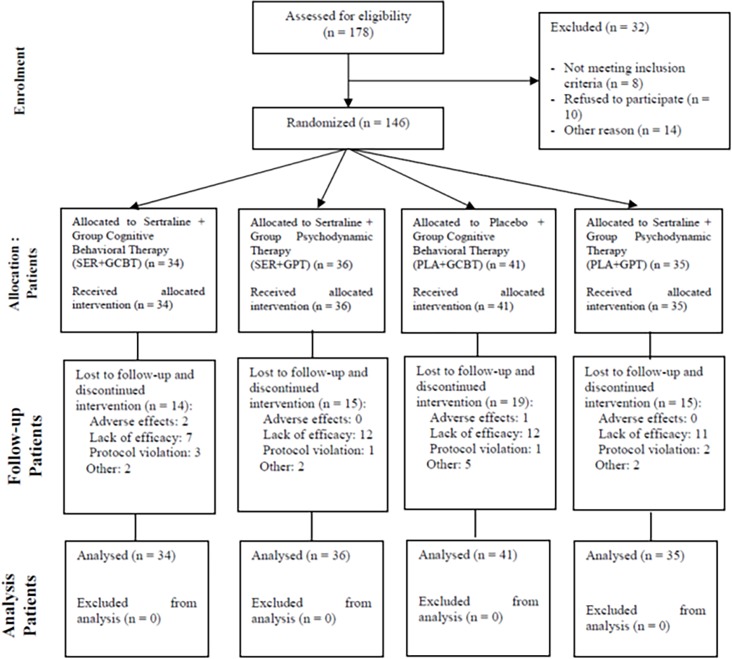
Consort flow chart.